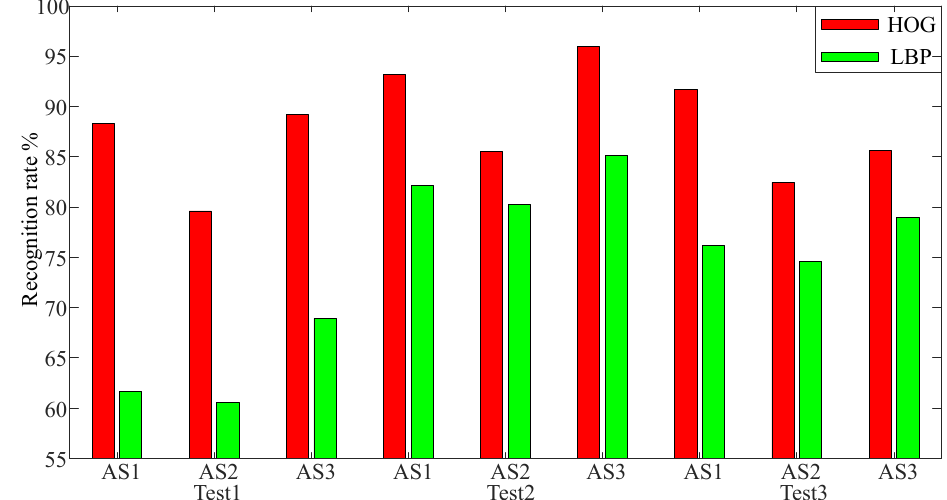
Figure 10. The recognition rate of MSTM when HOG features and LBP features are